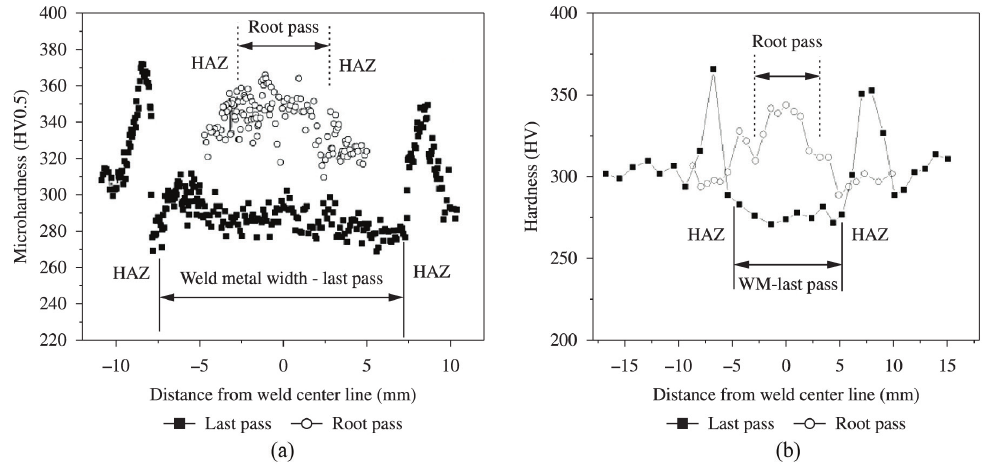
Figure 3. Microstructures of as welded specimens: (a) HAZ; (b) weld metal – root; (c) weld metal-middle; (d) weld metal-finished